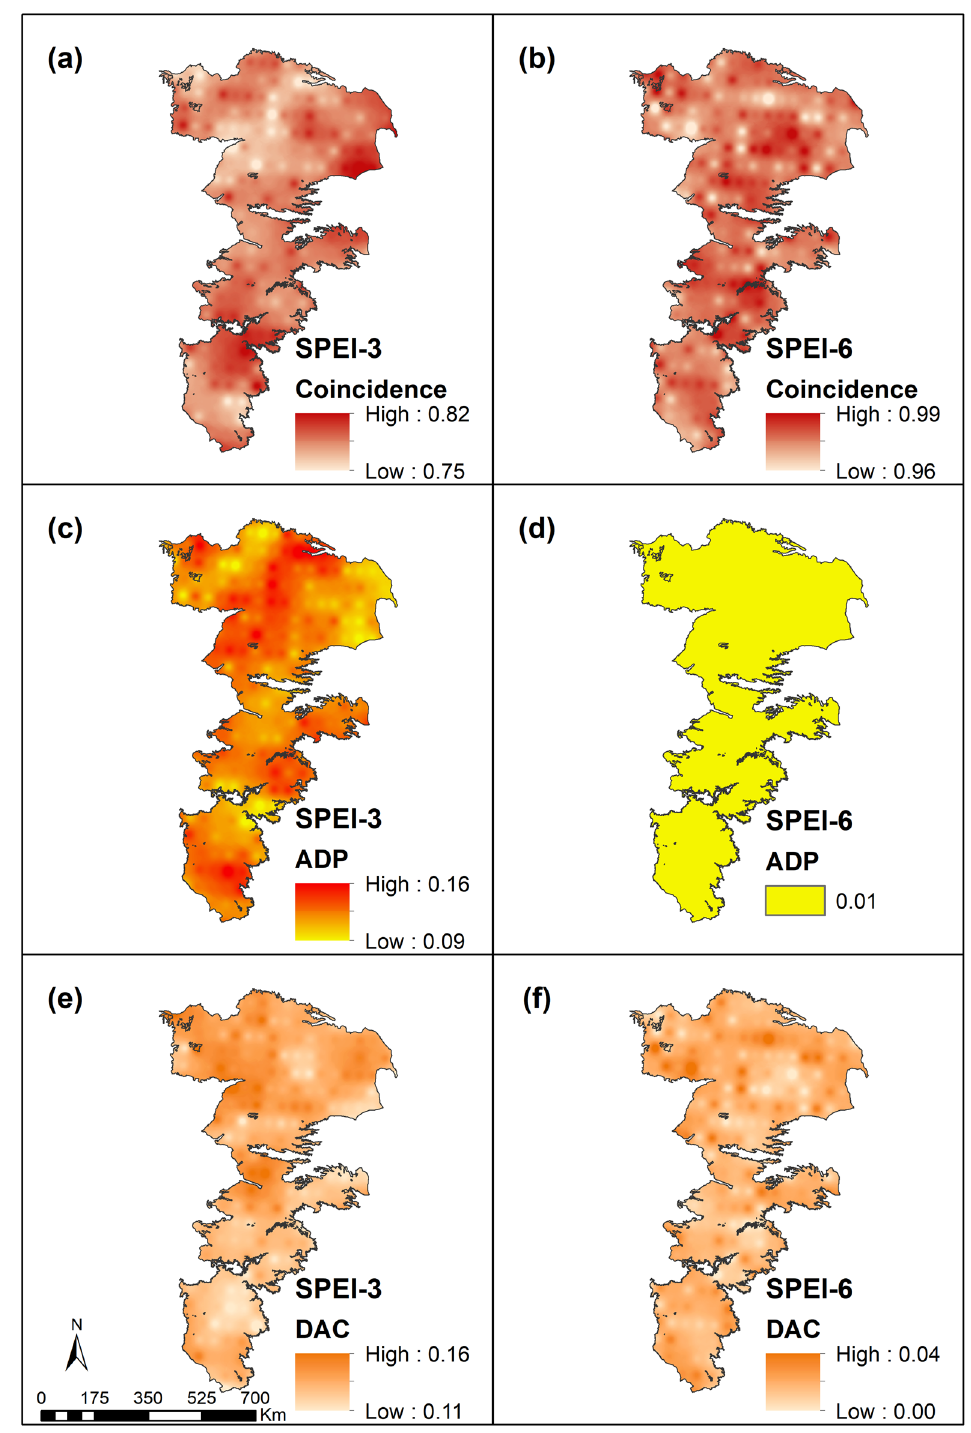
Figure 9. Comparison of meteorological (SPEI) and agricultural (SSMI) drought